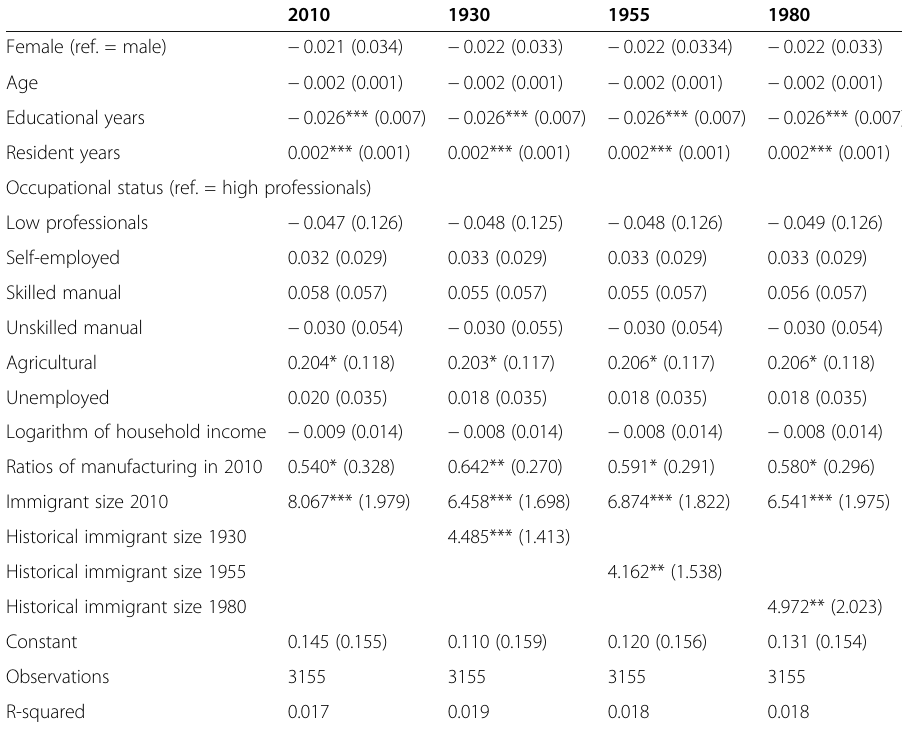
Table 4 OLS regression models of Japanese residents ’ xenophobia 2010 1930 1955